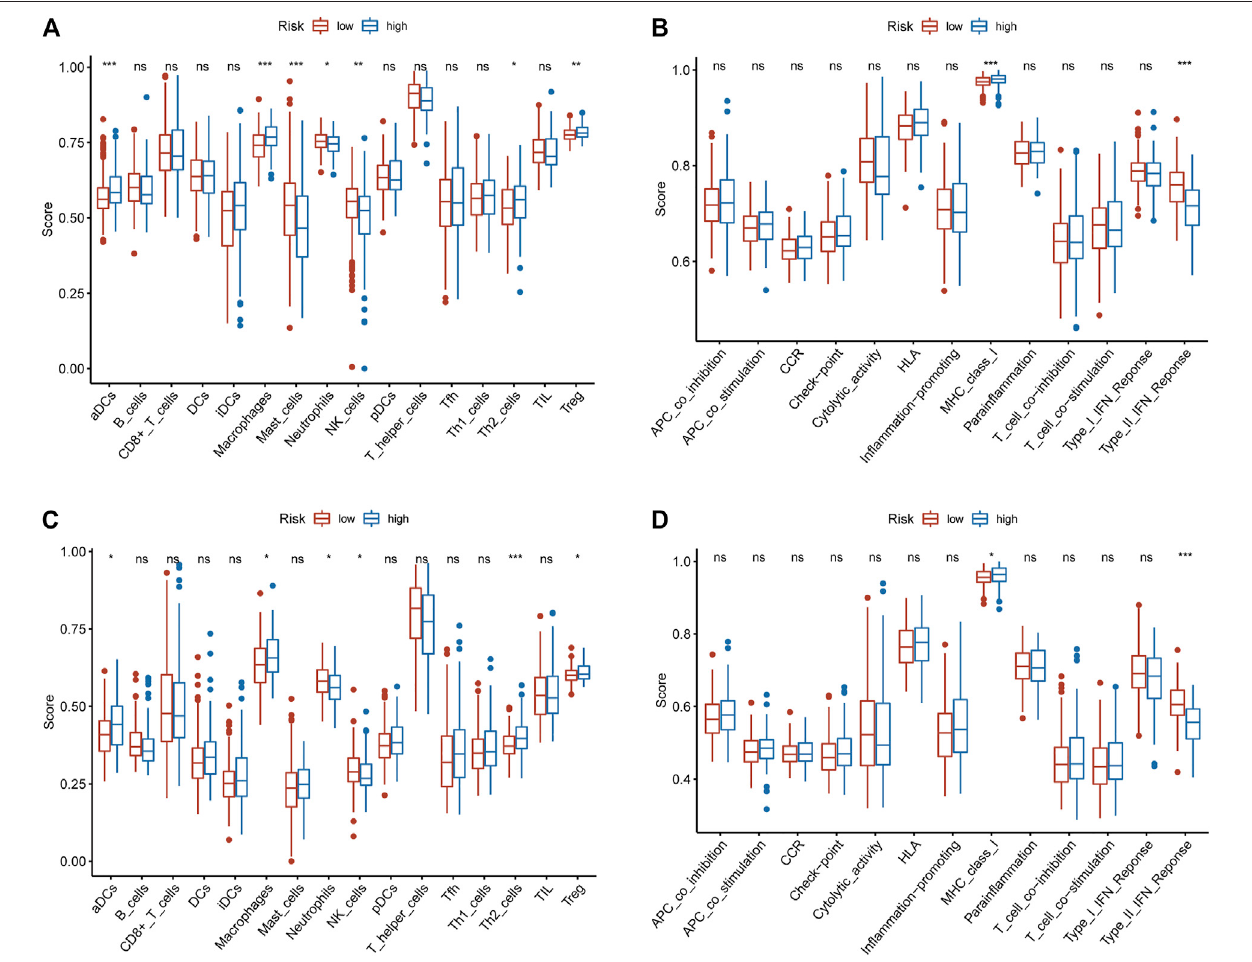
FIGURE 4 | The relationship between the IRGPs signature and immune in fi ltrating cells and immune-related functions. (A) The relationship between the IRGPs signature and immune cells in the TCGA cohort. (B) The relationship between the IRGPs signature and immune-related functions in the TCGA cohort. (C) The relationship between the IRGPs signature and immune cells in the ICGC cohort. (D) The relationship between the IRGPs signature and immune-related functions in the ICGC cohort. The adjusted p value is ns, which is not signi fi cant. * p < 0.05; ** p < 0.01; *** p < 0.001.